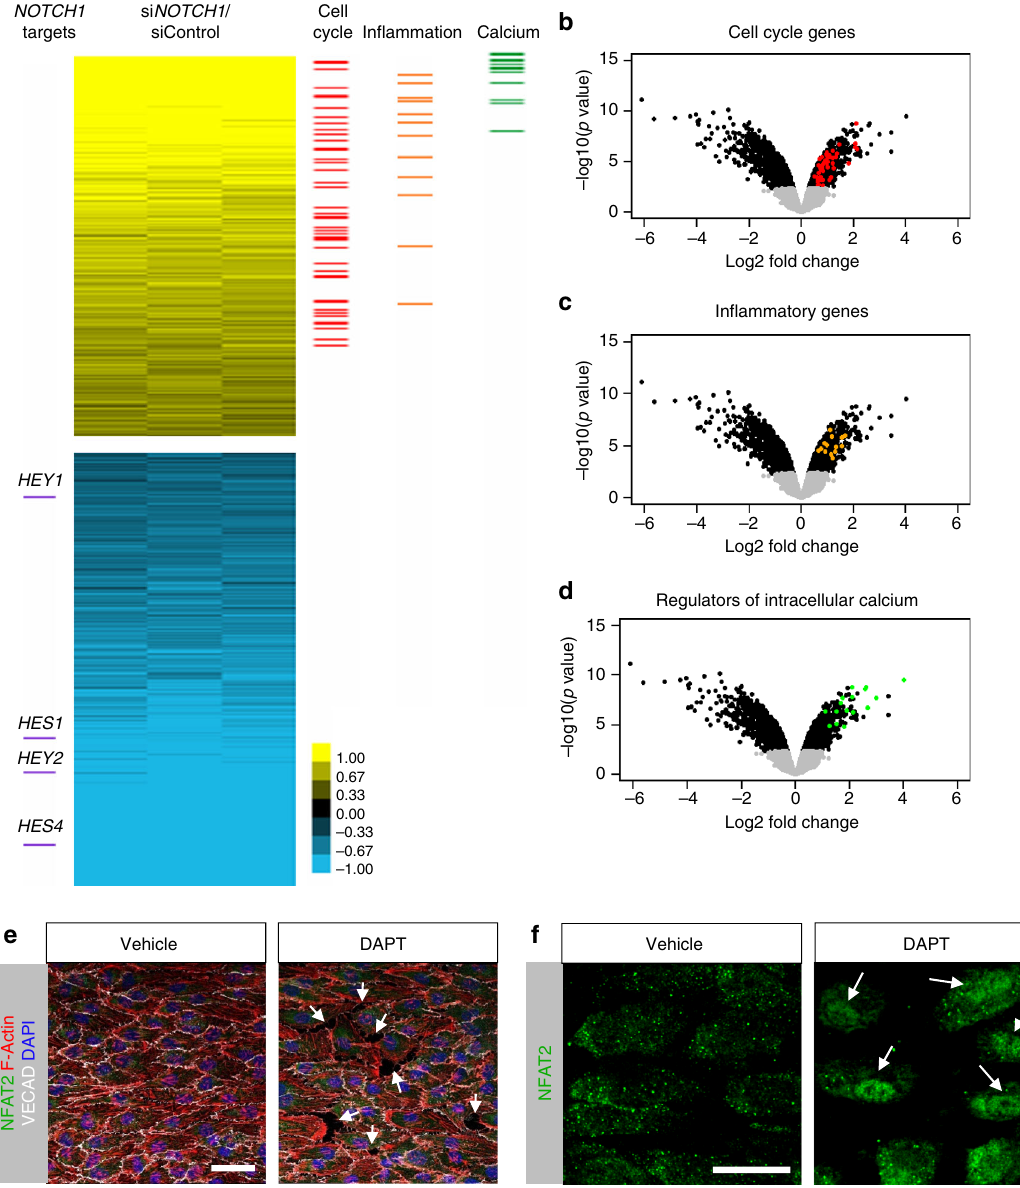
Fig. 6 Transcriptome of siNOTCH1 indicates changes in cell cycle, in fl ammatory genes, and regulators of calcium. a Cultures of HAECs treated with siNOTCH1 and siControl were analyzed for transcriptional changes by microarray. Heatmap to display differentially expressed genes ( ≥ 0.5 (log2) upregulated or ≤ − 0.5 (log2) downregulated with P < 0.001) marking NOTCH1 target genes and upregulated cell cycle, in fl ammatory genes and regulators of intracellular calcium. ( b – d ) Volcano plot visualization of the differentially expressed genes between siNOTCH1 and siControl. Colors indicate as follows: gray — no differential expression, black — genes whose fold change is either ≤ 0.50 or ≥ 1.5, red — genes known to contribute to the regulation of cell cycle, orange — genes involved in in fl ammation, and green — genes known to be regulators of intracellular calcium. ( e , f ) Confocal images of HAECs exposed to fl ow for 48 h in the presence of γ -secretase inhibitor DAPT or vehicle and stained for F-actin, VECAD, and NFAT2. Note the presence of nuclear NFAT2 and gaps between cells only in DAPT-treated monolayers (marked by white arrows). Scale bars = 20 µ